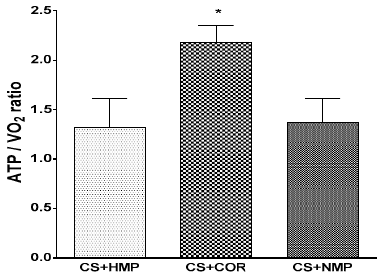
Figure 1. Efficiency of oxygen utilization as measured by tissue content of adenosine triphosphate (ATP) in relation to total oxygen consumption upon isolated reperfusion after 18h of cold storage and 90 of reconditioning machine perfusion; CS+HMP: oxygenated hypothermic machine perfusion; COR: controlled oxygenated rewarming prior to warm reperfusion, i.e., gradually increasing temperature over time; NMP: normothermic machine perfusion. (* p < 0.05 vs other groups, Student–Newman–Keuls